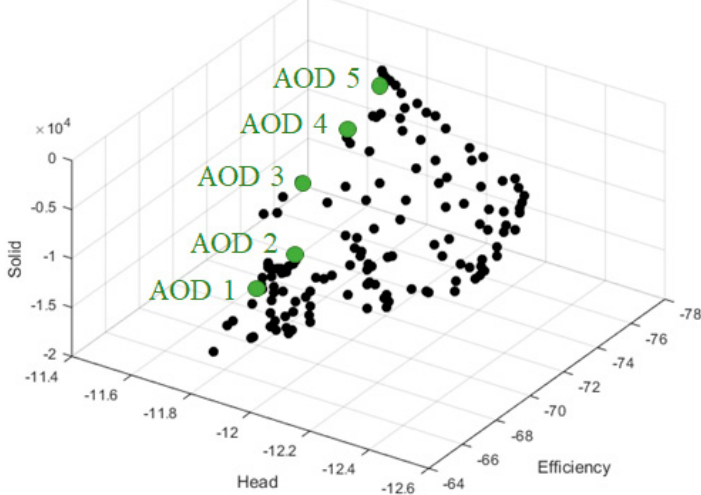
Figure 13. Pareto-optimal front surface with arbitrary optimal designs (AODs).